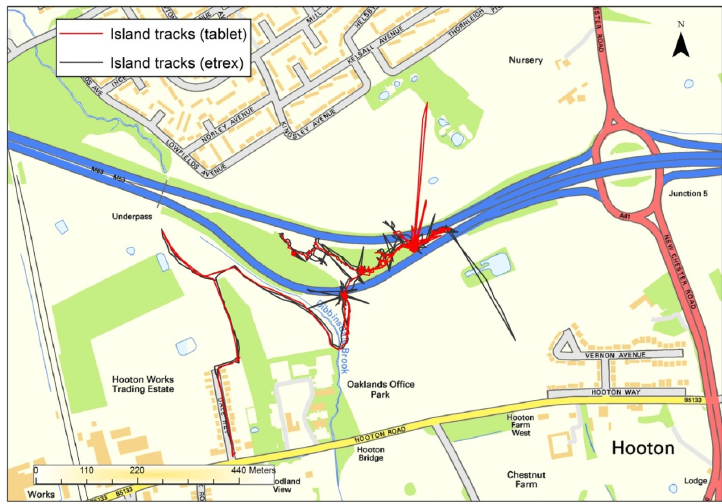
Figure 16. Map showing GPS tracks of island field visit, 22–23 August 2013 (1:5500) (Base map data: © Crown Copyright and Database Right [2013], Ordnance Survey (Digimap